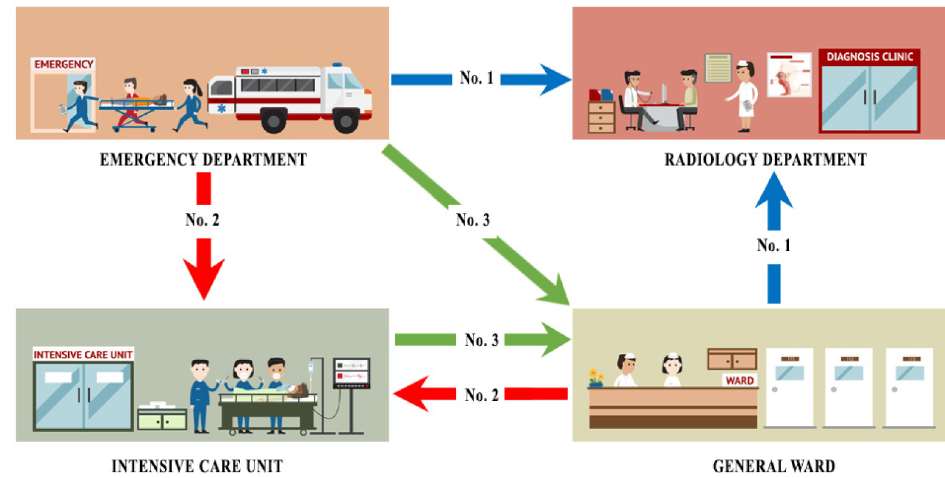
Fig 1. Intra-hospital patient transfer workflow from departure facility to another